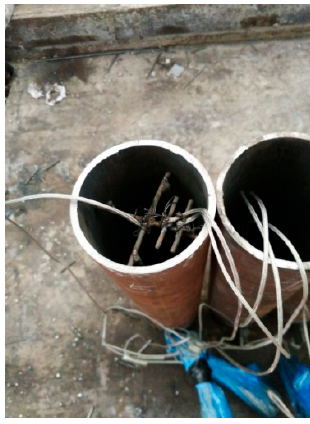
Figure 4. Arrangement of the thermocouples. ( a ) Specimen size; ( b ) Positions of thermocouples; ( c ) Numbers of thermocouples.